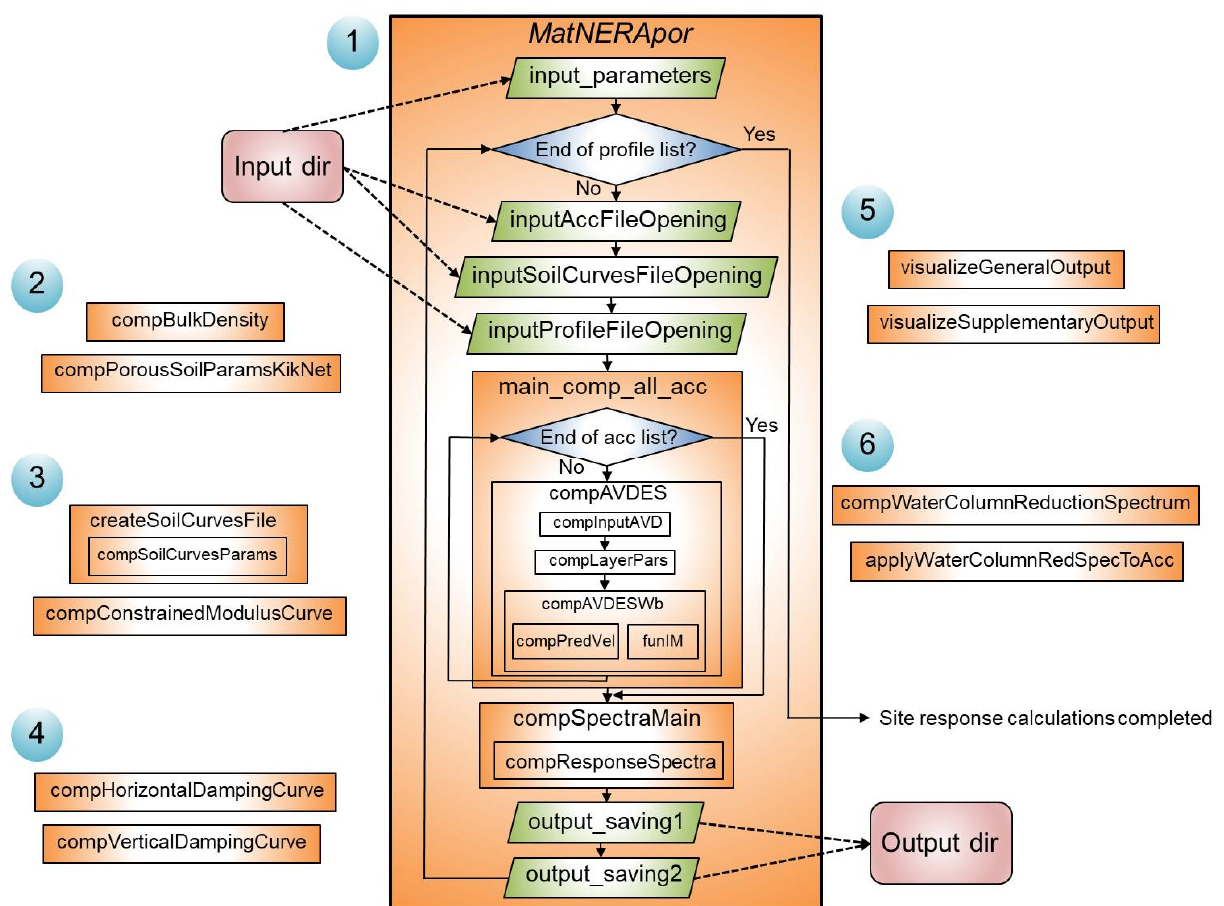
Figure 6. Block-scheme of MatNERApor Matlab package for numerical modeling of nonlinear response of porous saturated soil deposits to seismic body waves propagation. Numbers in blue circles—subsets of the package (see description in text).